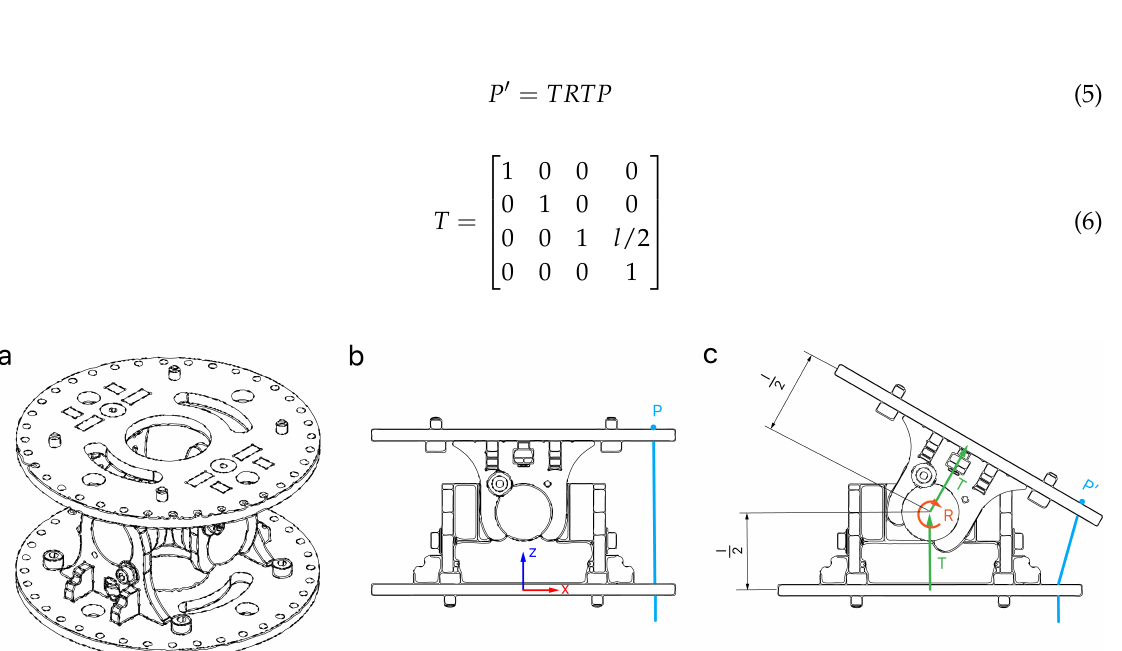
Figure 10. ( a ) Obtaining the displacements of the cables for a single joint. ( b , c ) Transformation of the pull point P to P (cid:48) after a joint rotation.